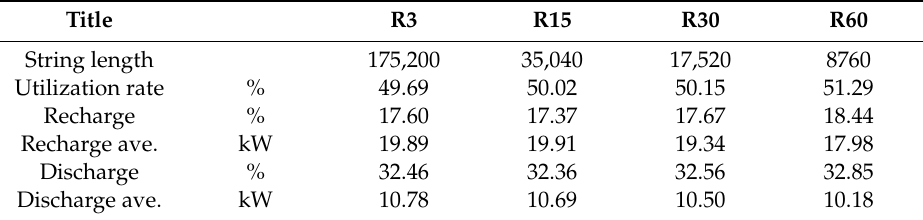
Table 7. Storage system